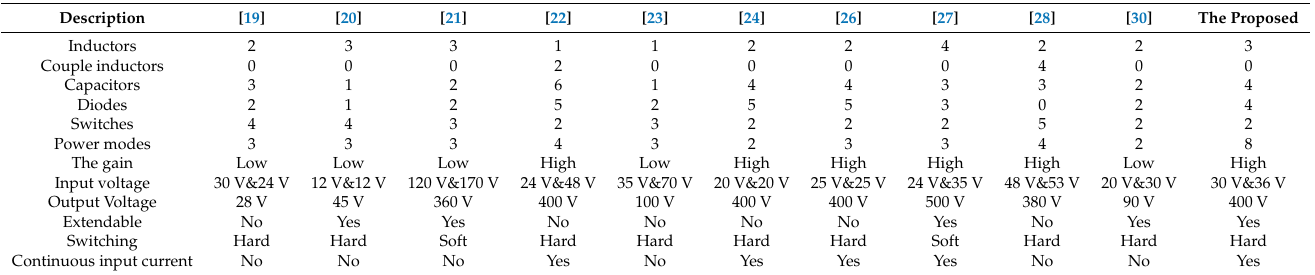
Figure 29. The simulation results of the DC bus voltage—the grid voltage—the load voltage—the injected current from the PV to the load in standalone, and in grid-tied power mode. Table 2. Comparison of the proposed TPC with other